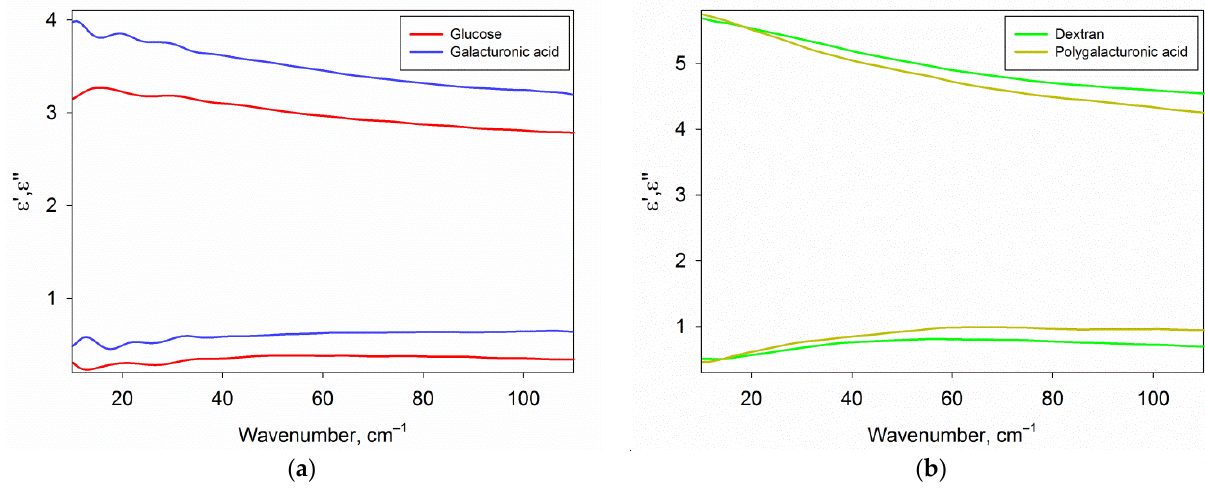
Figure 3. The real ε’ (top) and imaginary ε” (bottom) parts of the DPs of carbohydrates. Panel ( a ) contains DPs of amorphous monosaccharides (glucose and galacturonic acid), panel ( b ) contains DPs of polysaccharides (dextran and polygalacturonic acid).